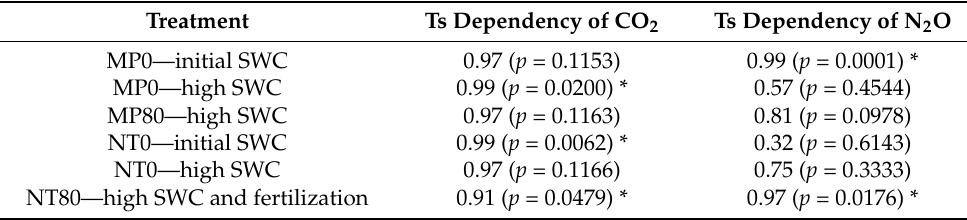
Table 8. Correlation and significance * of Ts and greenhouse gas (GHG) emissions; r 2 and p -values are indicated (Sample numbers are presented in Table